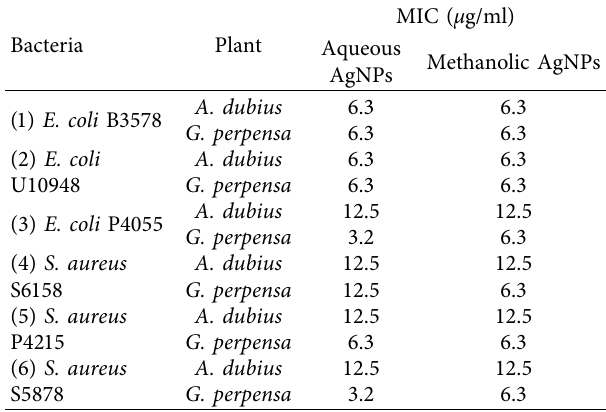
Table 2: Minimum inhibitory concentration of AgNPs synthesized from aqueous and methanolic leaf extracts of A. dubius and G. perpensa .